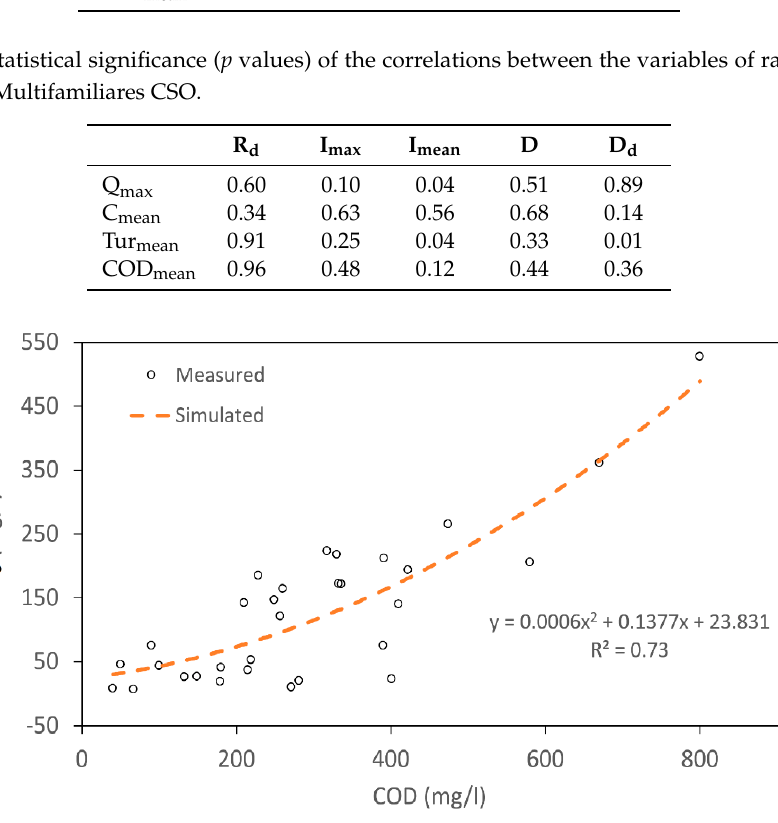
Figure A1. Adjustment of the relationship between BOD 5 and COD using quadratic regression.